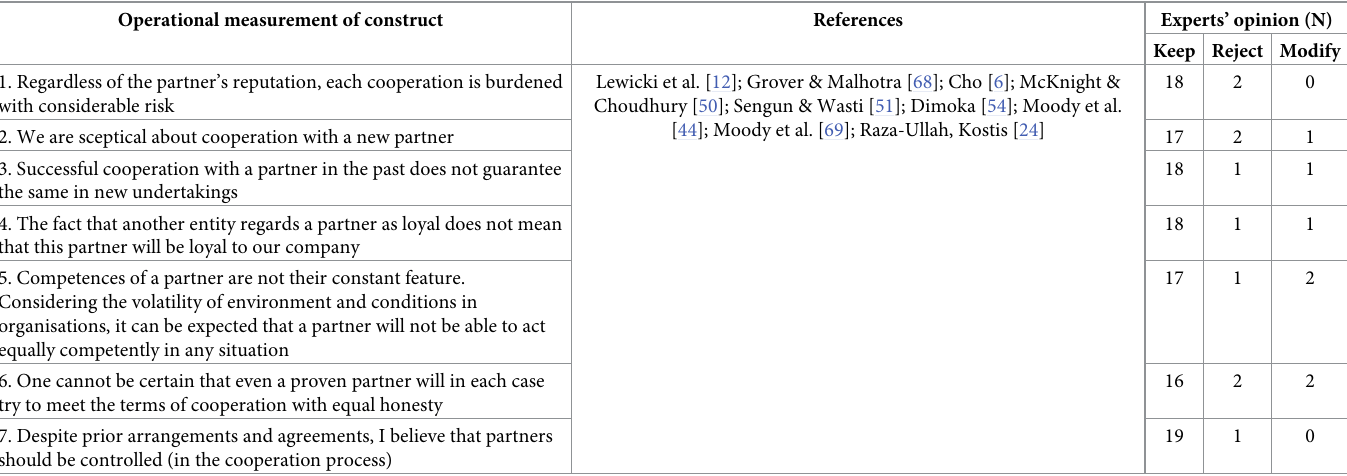
Table 4. Operationalisation of the construct of distrust of partners as latent variables. Operational measurement of construct